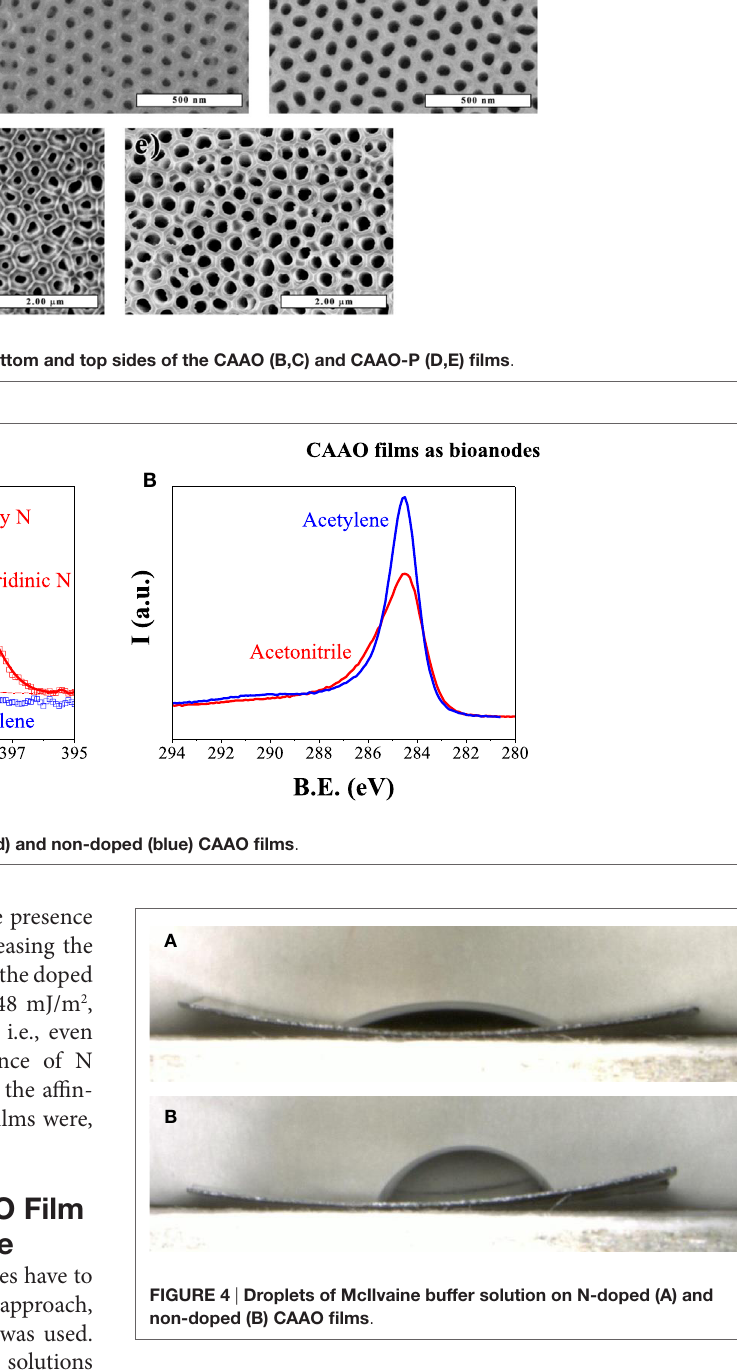
FigUre 4 | Droplets of Mcilvaine buffer solution on n-doped (a) and non-doped (B) caaO films .